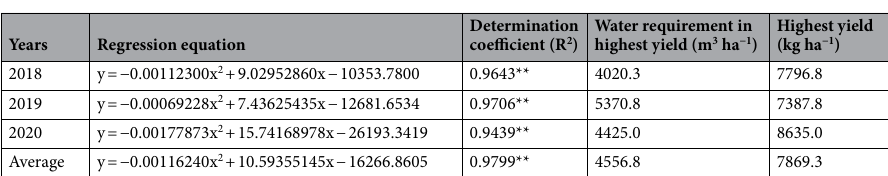
The results (Table 6) show that there is a significant positive correlation (r > r0.01) between the water require- ments of rice cultivated with drip irrigation under plastic film-mulched and yield. The rice yields in 2018–2020 plotted against the water requirement can be described with a quadratic function. The highest water demand and its highest yield were calculated by this equation. The highest water demands in 2018, 2019 and 2020 were 4020.3, 5370.8 and 4425.0 m 3 ha −1 , respectively. The highest yields were 7796.8, 7387.8 and 8635.0 kg ha −1 , respectively. The 3a regression equation was obtained by using the 3a water demand and the production average allocation equation. The average water demand was 4556.8 m 3 ha −1 , and the highest yield was 7869.3 kg ha −1 . When the water demand for rice was lower than that associated with the highest yield, the yield of rice increased with increasing in water demand. When the water requirement of the growth period was higher than the highest